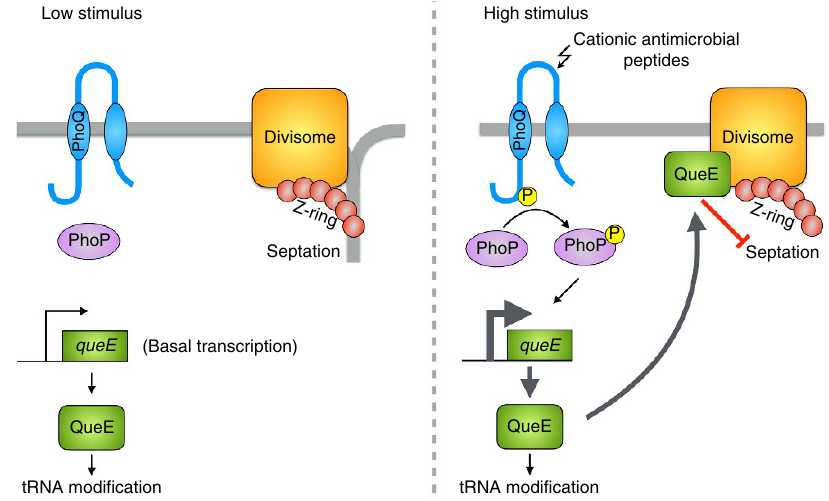
Figure 6 | E. coli PhoQ/PhoP two-component system modulates cell division via QueE. PhoQ repression by high extracellular magnesium leads to low levels of phosphorylated PhoP (PhoP-P) and basal expression of QueE, sufficient for QueE’s function in the queosine tRNA modification pathway. Septation is unaffected. Strong stimulation of PhoQ by cationic antimicrobial peptides leads to an increase in levels of PhoP-P, which results in increased transcription of queE . When cells produce high levels of QueE, the protein associates with the divisome and inhibits